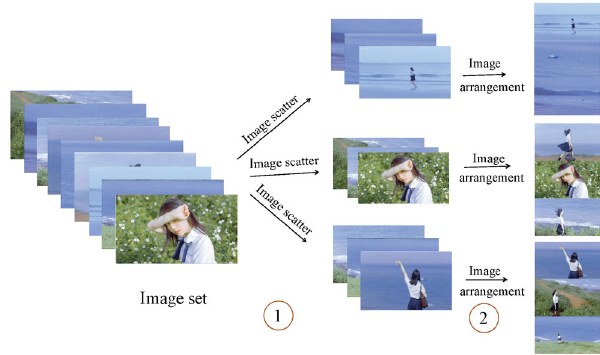
Fig. 2 Workflow of MPC